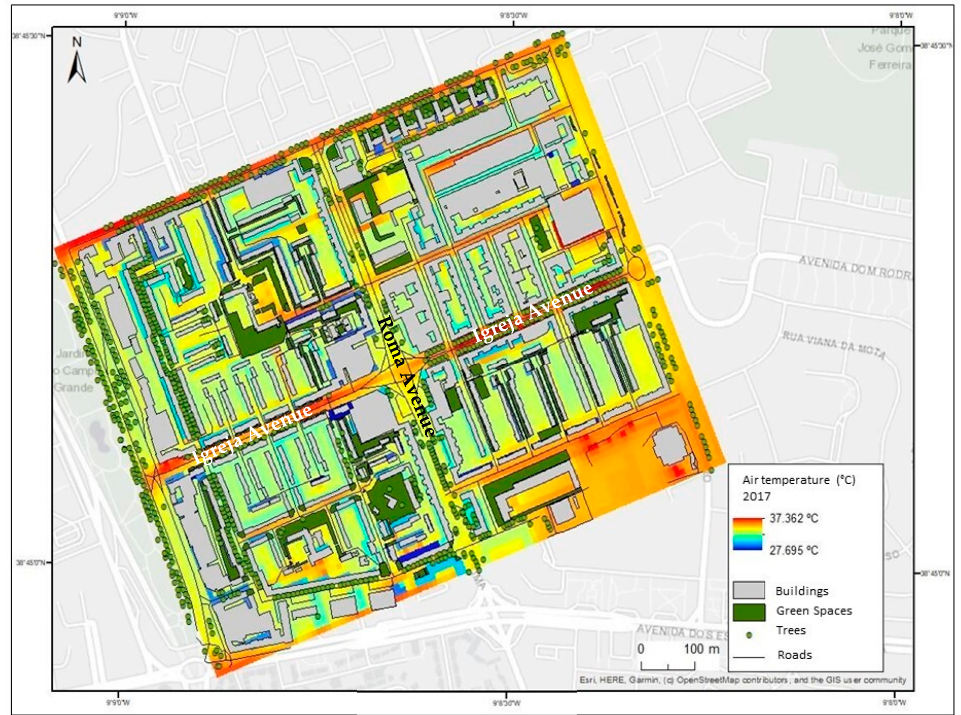
Figure 5. Present model—Air temperature of a recent hot day in the present situation (3 July 2017).